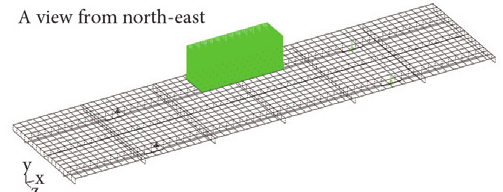
Fig. 3. Example of 3D model of the superstructure of the bridge